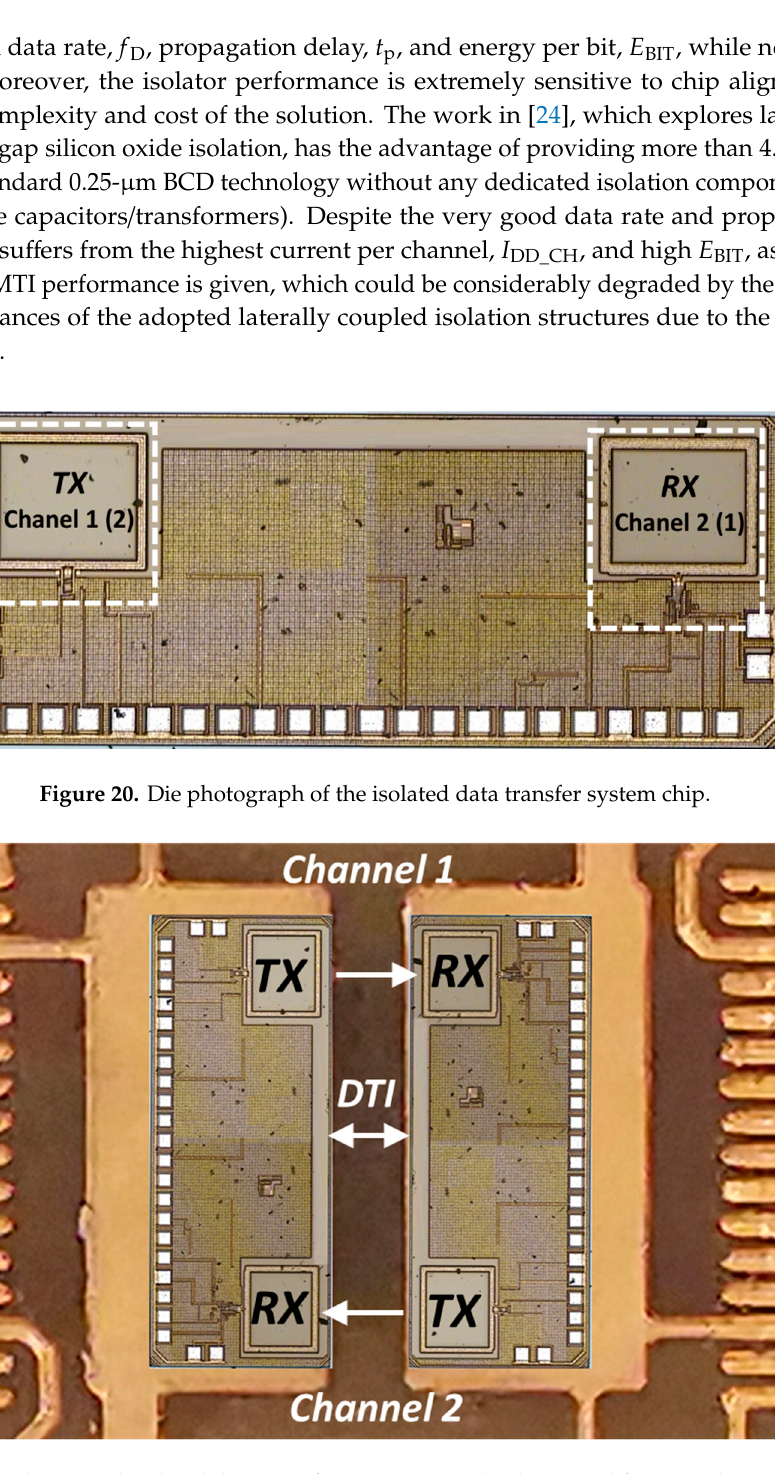
Figure 19. Isolated data link simulations in the presence of a 250-kV/µs common mode (CM) disturbance ( f D = 40Mb/s, Montecarlo (MC) runs = 200, σ = 4). (a) D IN ; (b) RX antenna voltage; (c) D OUT ; (d) CK OUT ; (e) common mode transients (CMTs).